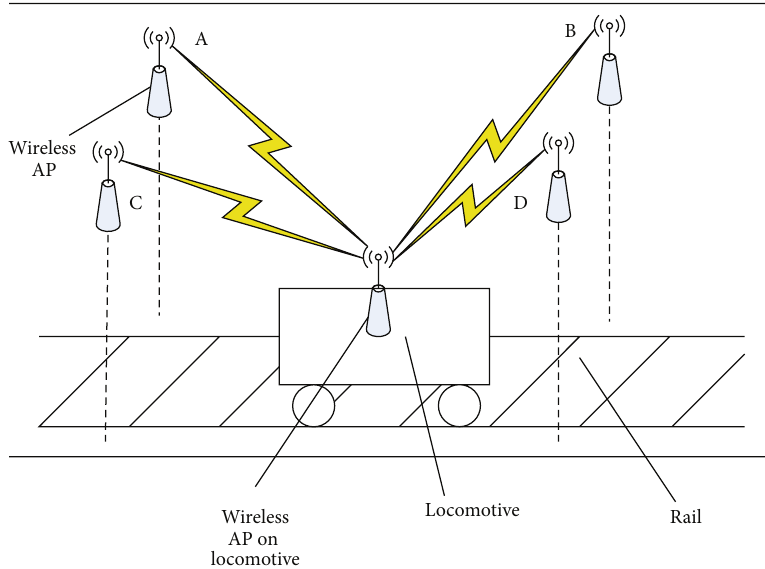
Figure 1: Wireless communication